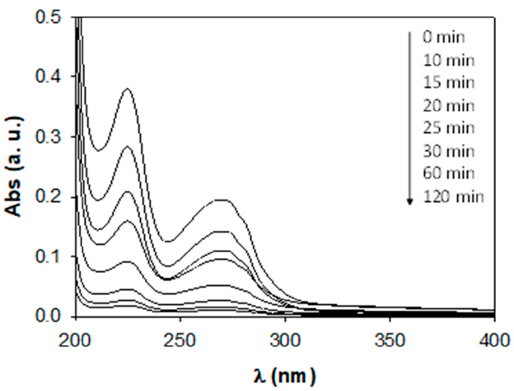
Figure 8. Variation of the UV–Vis absorption spectrum during the degradation of 10 ppm of ATL with 0.75 g·L − 1 of AgCl.